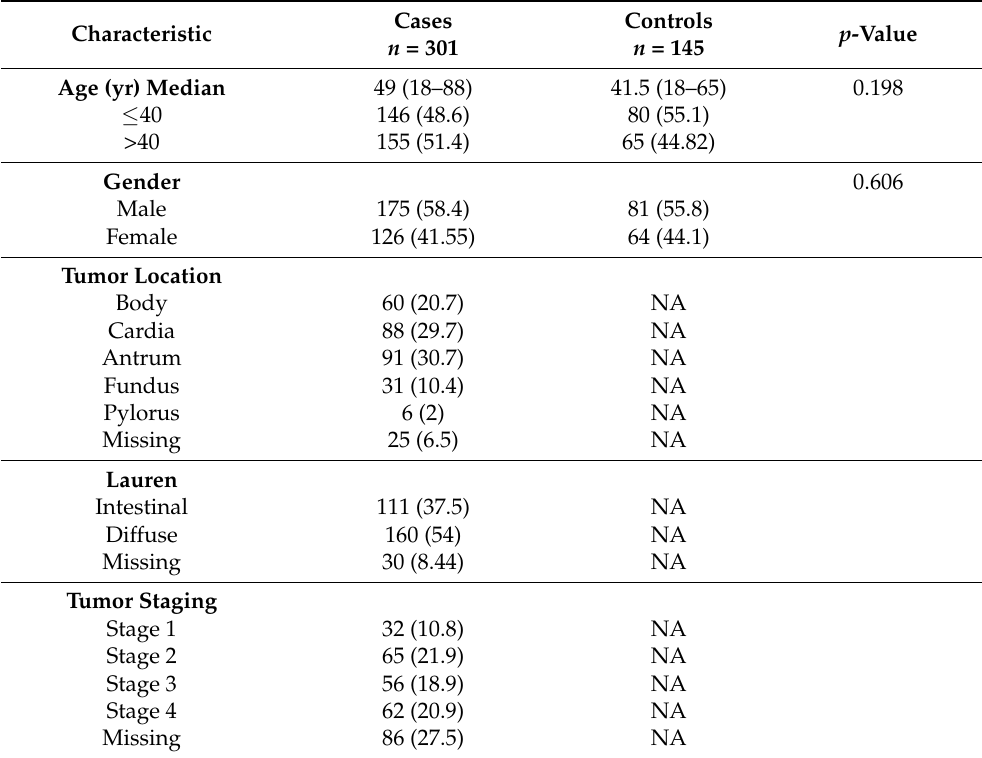
Table 2. Demographic data of gastric cancer cases and control.